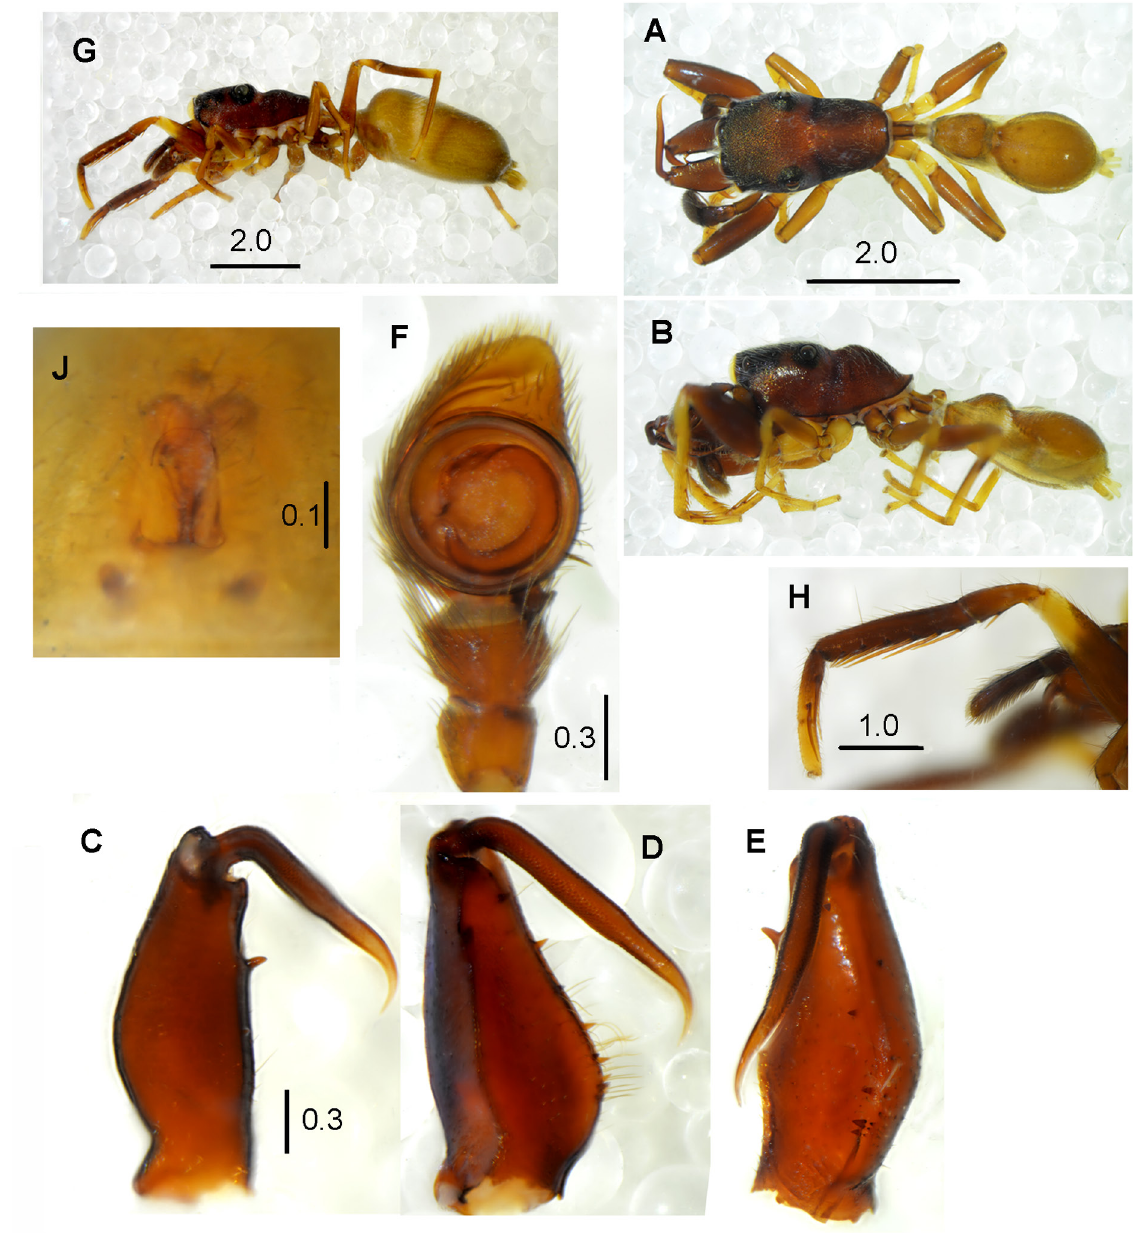
Fig. 11. Belippo milloti (Lessert, 1942), ♂♀ (MNHN). A . Habitus of male, dorsal view. B . Habitus of male, lateral view. C . Male chelicera, dorsal view. D . Male chelicera, ventral view. E . Male chelicera, prolateral view. F . Palpal organ, ventral view. G . Habitus of female, dorsal view. H . First leg of female, retrolateral view. J .